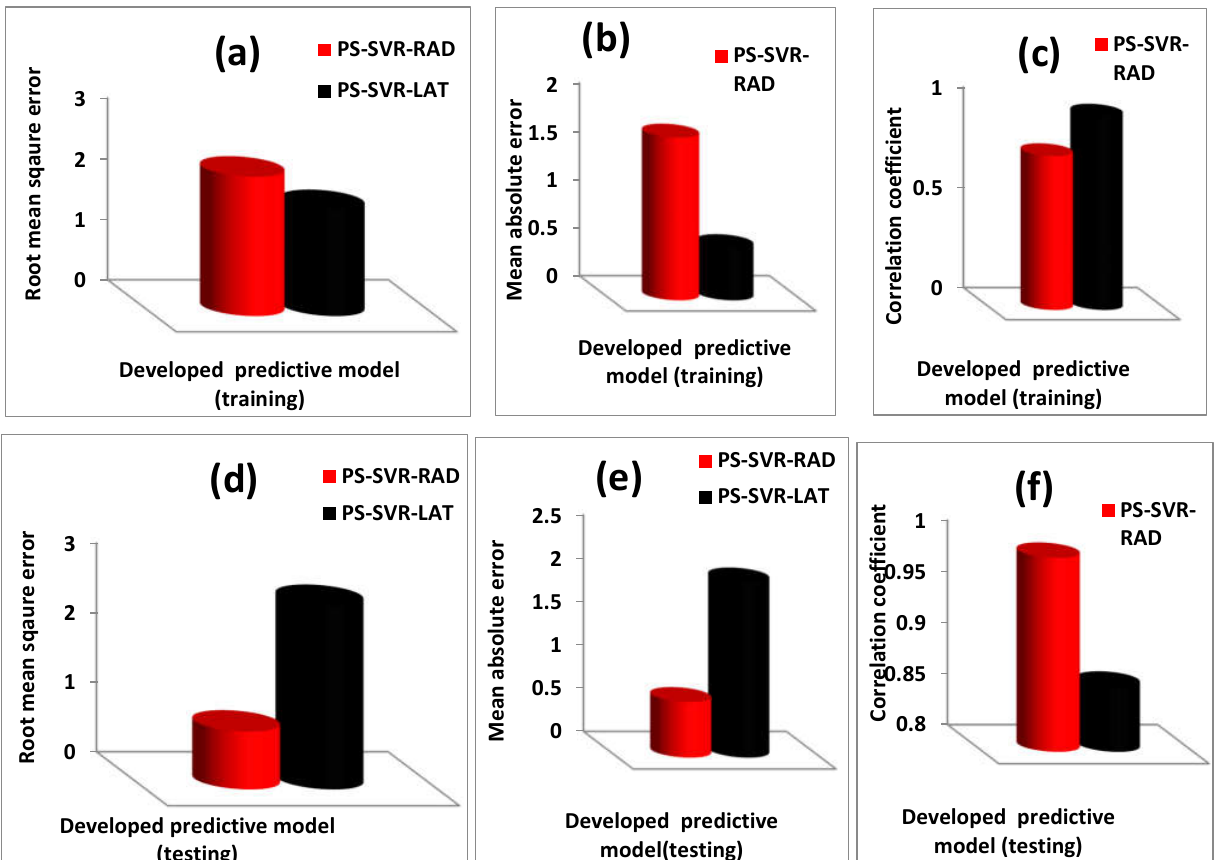
lute error as performance measuring criteria.